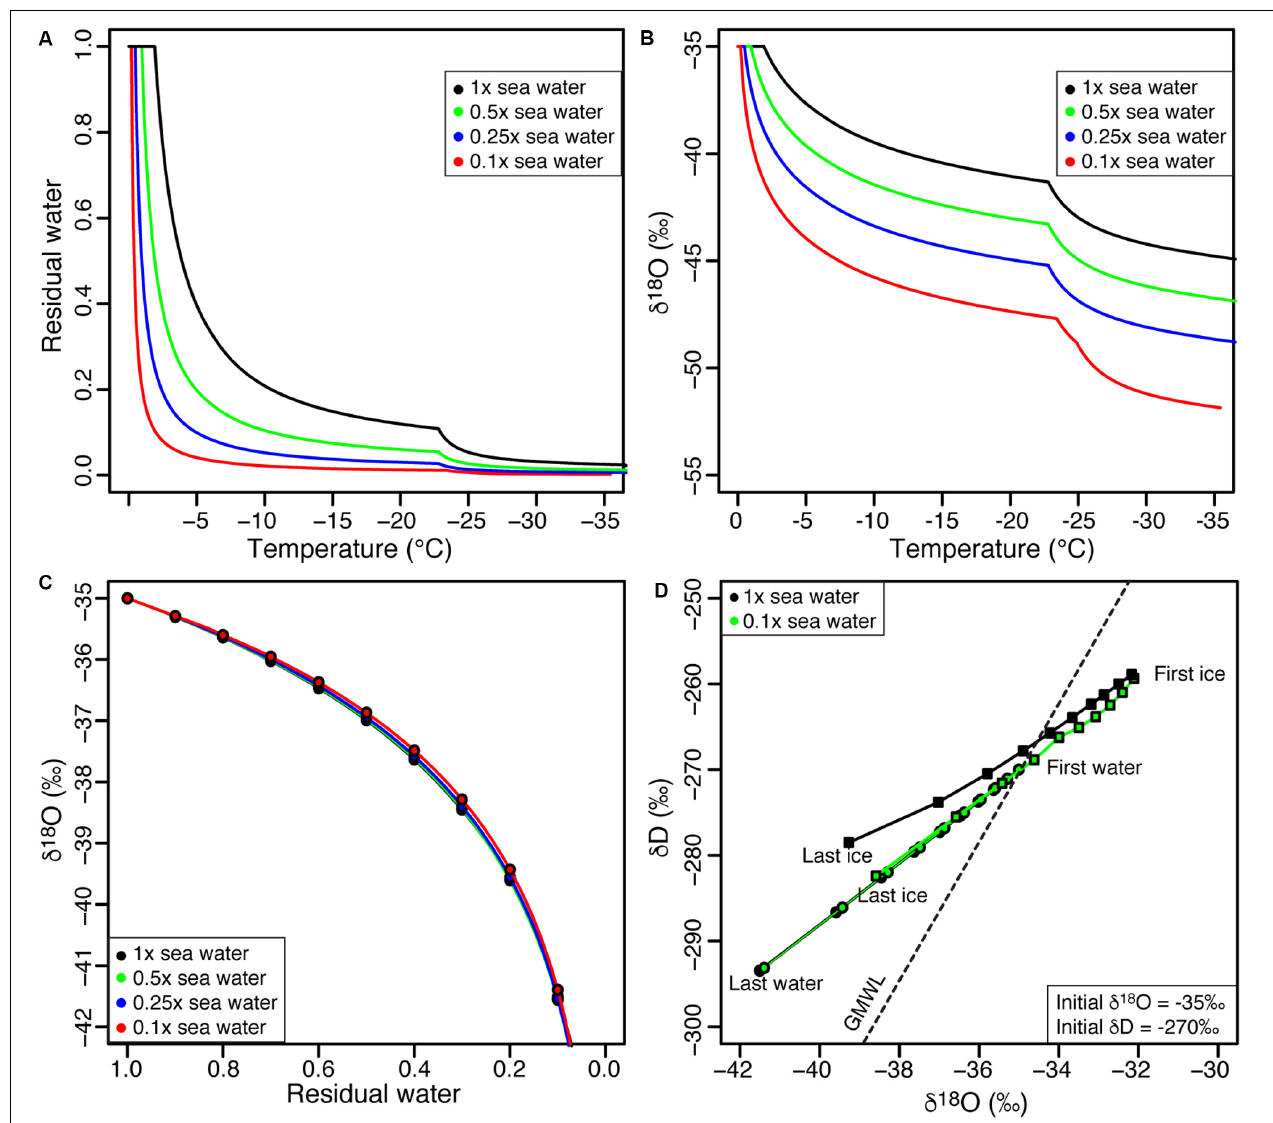
FIGURE 2 | Evolution of (A) residual water fraction and (B) δ 18 O of residual water during freezing as a function of various molalities of sea water; (C) relation between δ 18 O and residual water for various molalities of sea water; and (D) δ D- δ 18 O evolution of liquid water and ice during freezing, using 100 and 10% sea water salinity solutions (circles = water; squares = ice). See Table 1 for values of input parameters used in